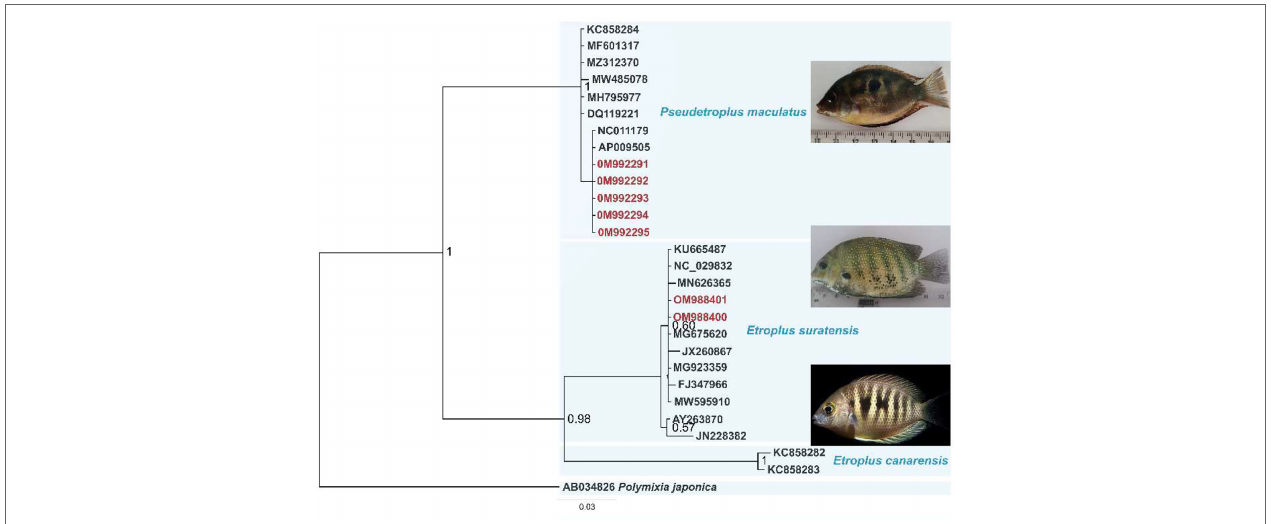
FIGURE 2 | Bayesian phylogenetic tree based on COI sequences retrieved from GenBank (accession numbers indicated) and the specimens from this study (red text). Branch labels are posterior probability and the scale bar is the number of substitutions per site. Polymixia japonica is used as the